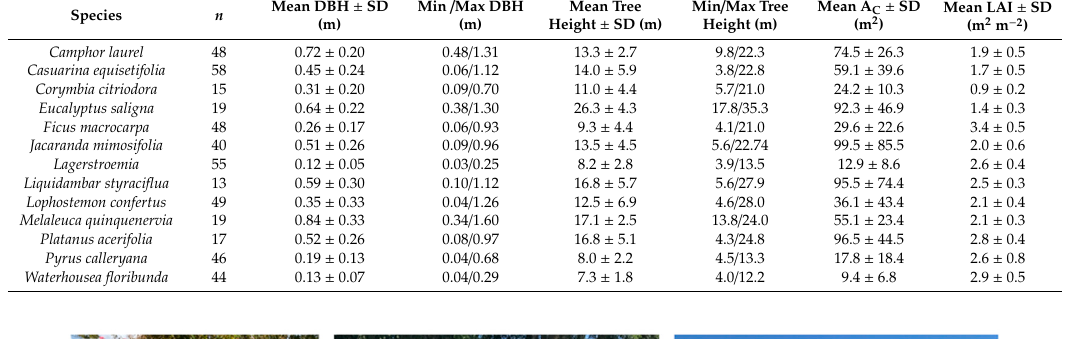
Table 1. Alphabetic list of tree species with their mean diameter at breast height (DBH), total height, vertical crown projected area (A C ) and leaf area index (LAI). N denotes number of trees. Minimum and maximum values for DBH and height, as well as 1 Standard Deviation (SD) are shown.